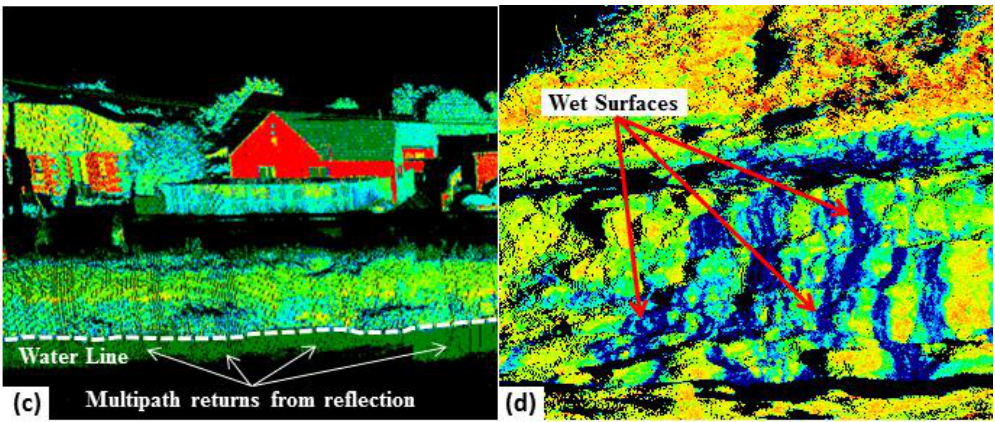
Figure 4. Examples of factors that influence intensity values. ( a ) Degraded intensity values with range on objects such as street lights and asphalt pavement; ( b ) dissimilar intensity values captured on walls with different angles of incidence (larger view in Figure 3g); ( c ) lower intensity values for multipath returns from reflections of the laser off of the water surface; and ( d ) degraded intensity values (blue) due to wet surfaces at a rocky intertidal